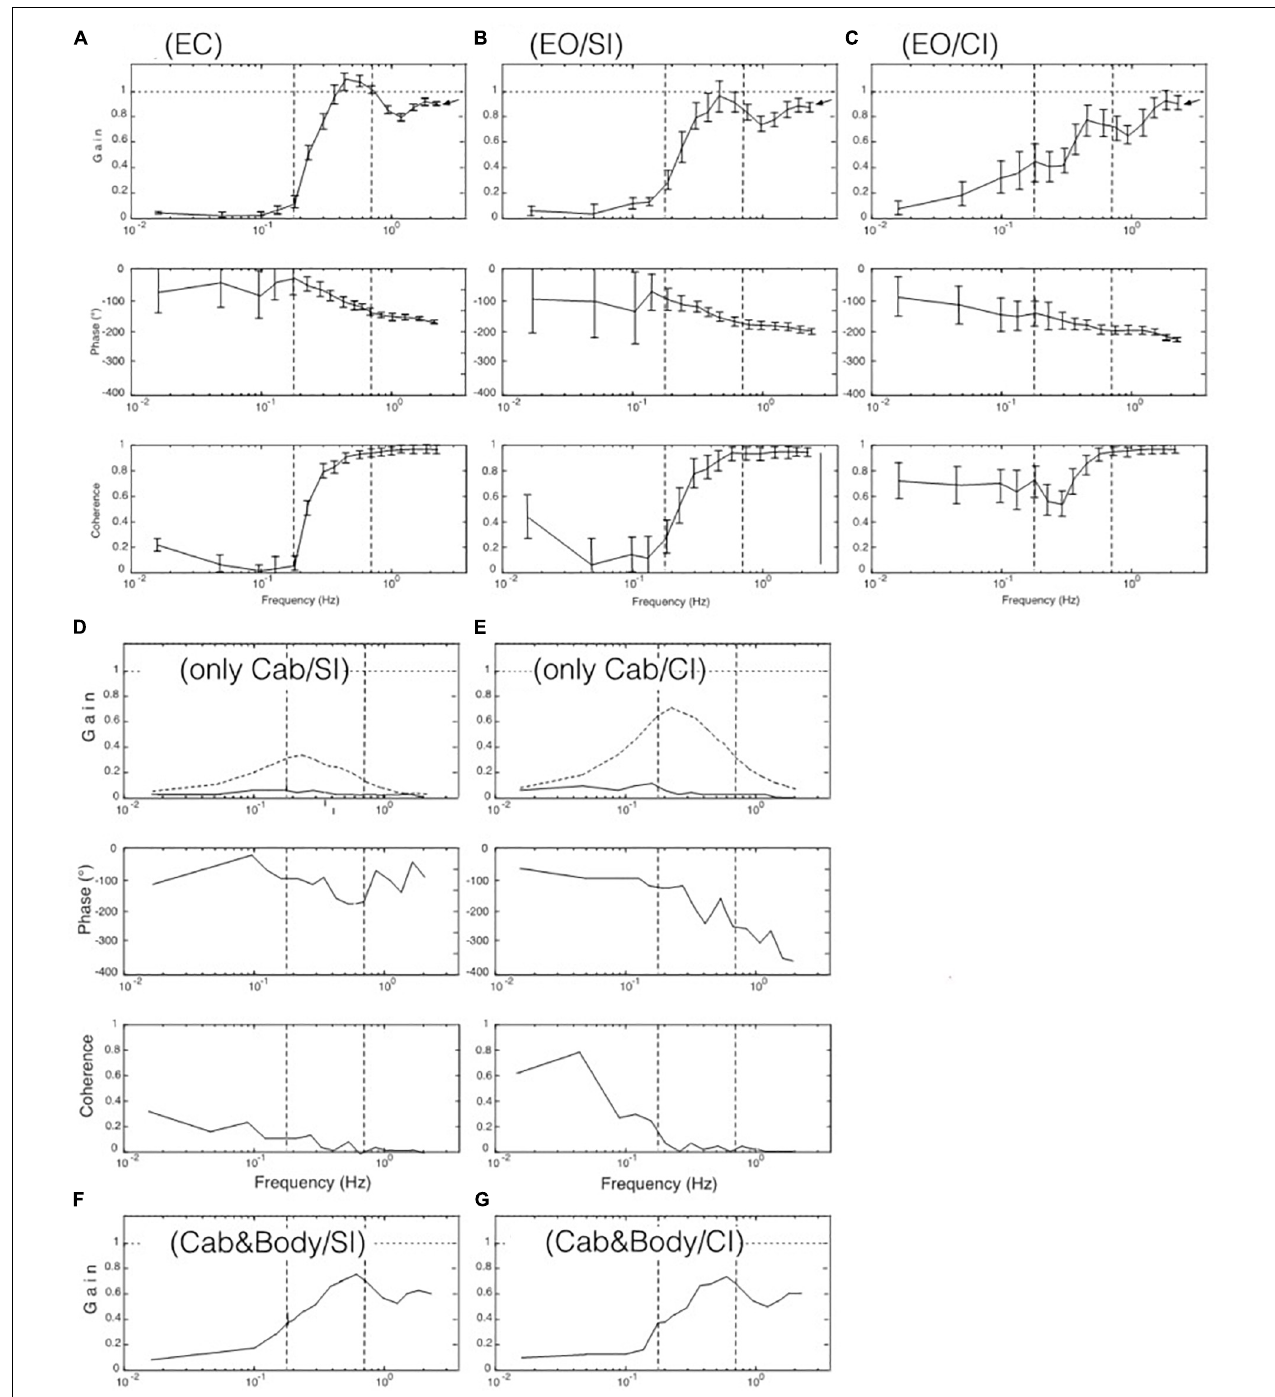
FIGURE 3 | Results from the seven experiments reflecting the seven tested viewing conditions listed in Table 1 . Shown are gain, phase, and coherence (in A–C with standard error values) in terms of gain, phase, and coherence over frequency. Dotted curves in panels (D,E) demonstrate discrepancy of obtained versus modeled data (see text). Curves in (F,G) represent “distorted” responses obtained with the cabin fixed on the translating body